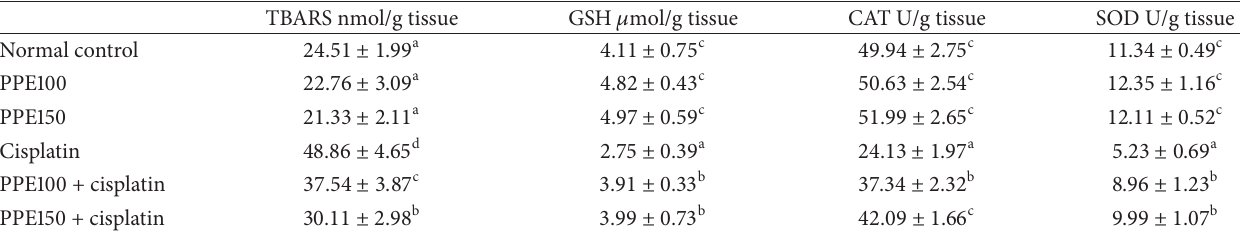
Table 5: Effect of Physalis peruviana L. extract on the kidney lipid peroxidation and antioxidant enzymes levels in normal and cisplatin induced ARI rats.